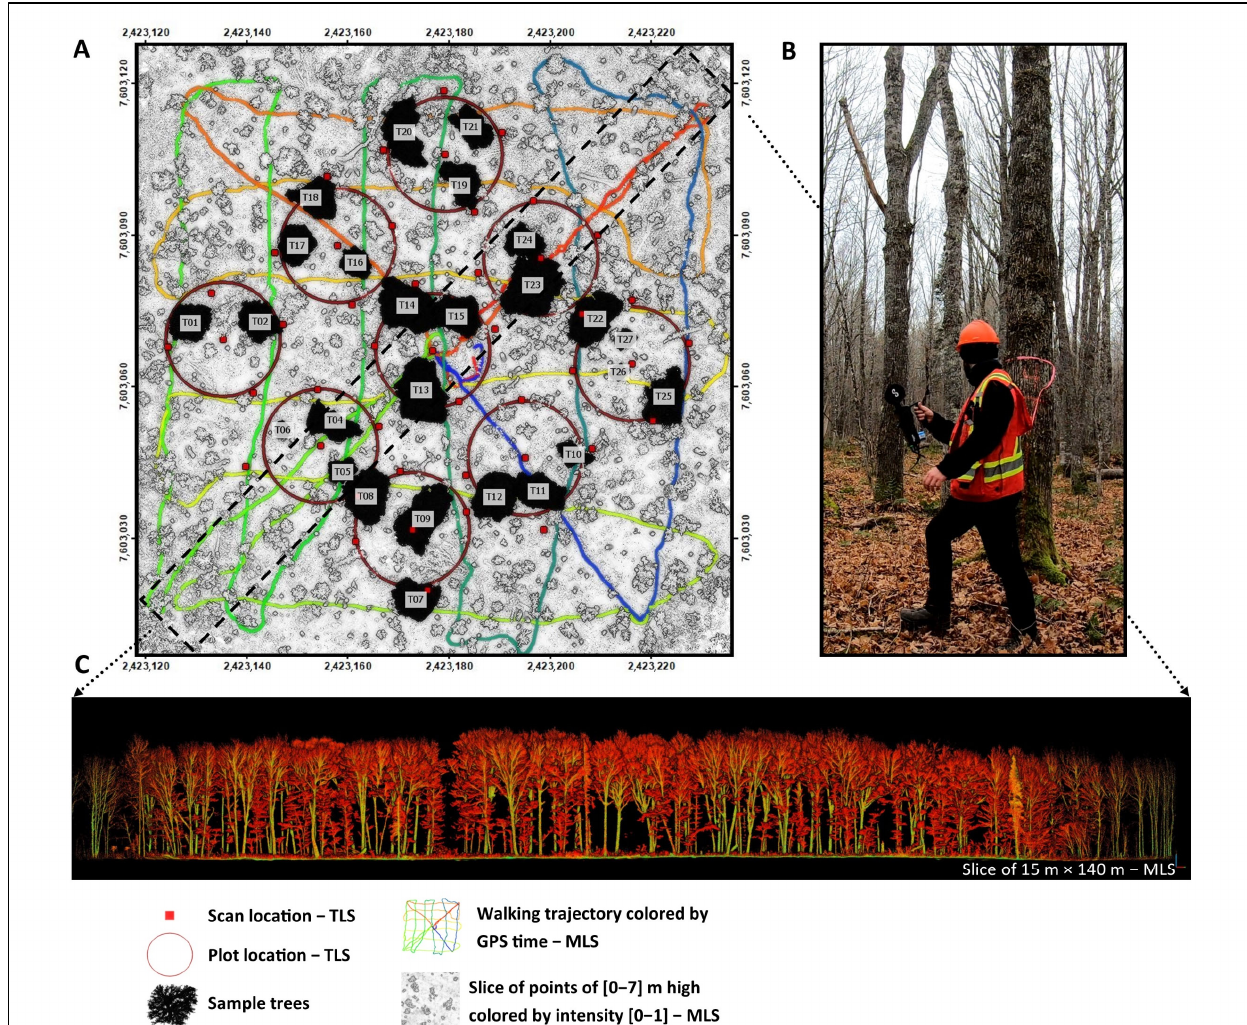
Figure 2. ( A ) Map of the 1 ha hardwood site (47°25 ′ 21.70 ″ N, 67°31 ′ 5.84 ″ W), showing the TLS and MLS data acquisition patterns, as well as the location of the 26 sample trees located on a MLS slice of points of 0–7 m high that illustrates the terrain and surrounding trees (NAD 1983 CSRS New Brunswick Stereographic); ( B ) Survey of the stand with the Hovermap MLS system; ( C ) A 15 m cross ‐ section of the 1 ha MLS point cloud on a 140 m diagonal colorized by intensity (low: red; high: